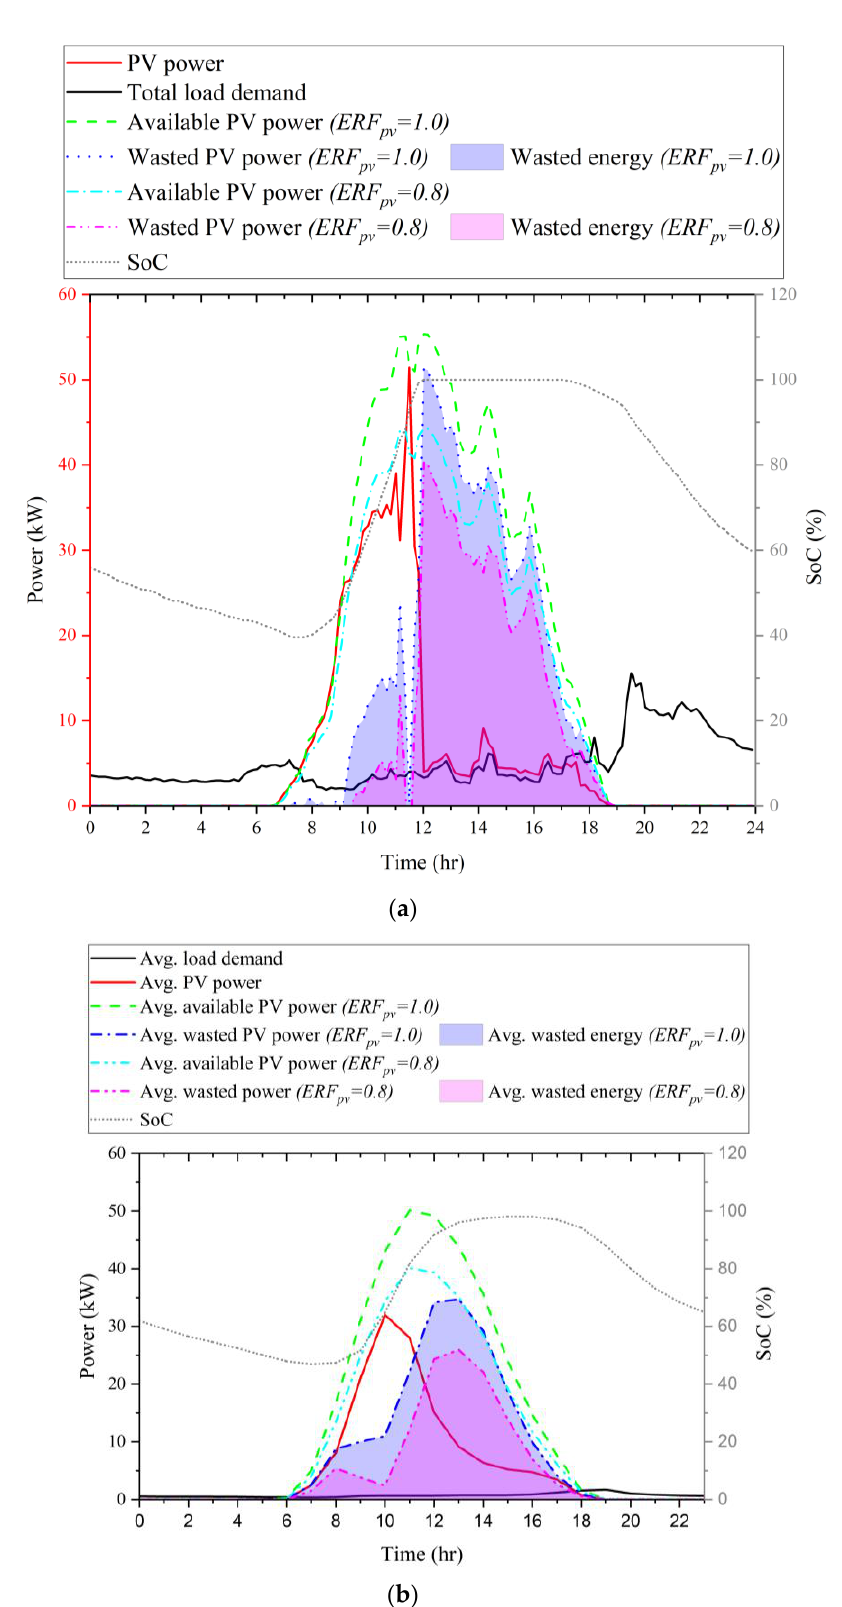
Figure 27. Illustration of mini-grid operation with significant curtailment of available PV power, after the battery is fully charged, due to a low total demand: ( a ) same day as in Figure 23, ( b ) average annual daily values/profiles.